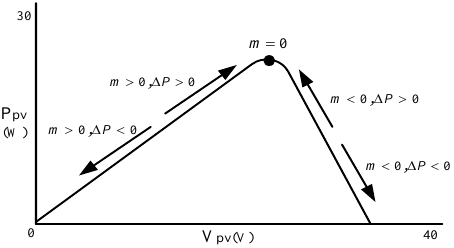
Figure 3. Slope ( m ) and changes in power ( ∆ P ) of the P–V characteristic curve determined through the power feedback method.